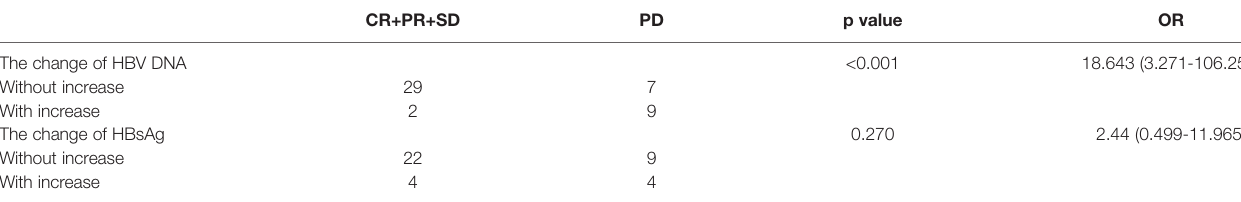
The change of HBV DNA